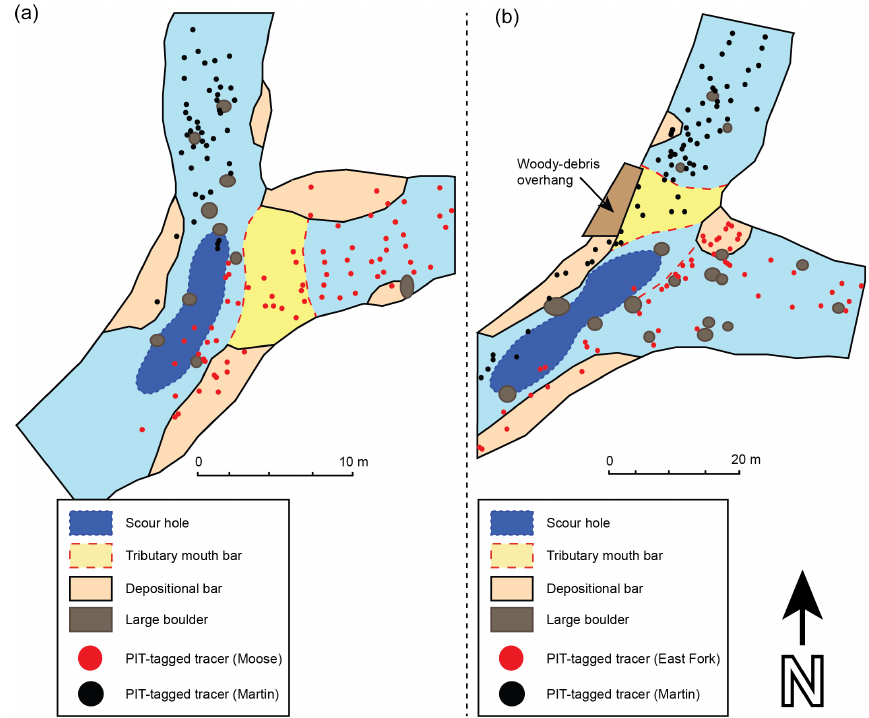
Figure 6. Digitized patch map of bedforms and tracer recovery positions at the (a) upper and (b) lower confluences. Table 3. Critical shear velocity ( U ∗ c ) and dimensionless impulse ( I ∗ ) at each study